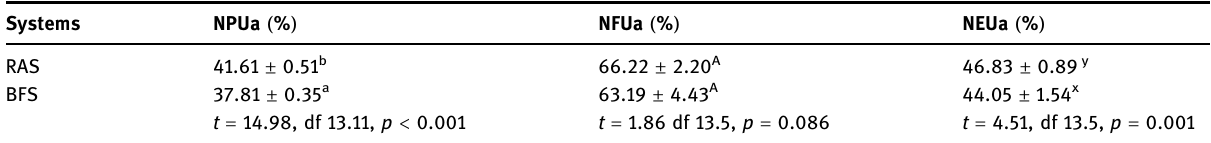
Table 3 : Apparent Net Nutrient Utilization of feed by Nile tilapia cultured in the recirculating aquaculture system and Stagnant water aquaculture system for 42 days Systems